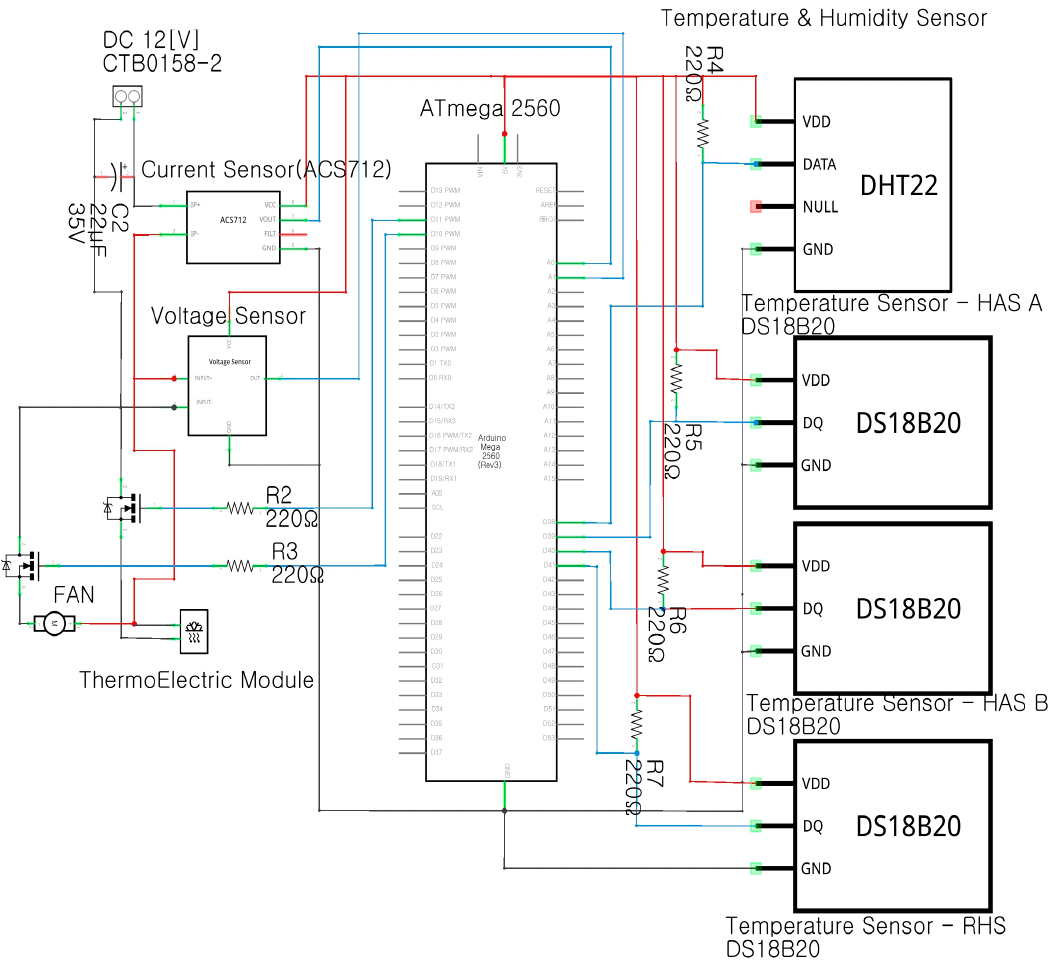
Figure 11. System structure and circuit diagram for experiment. Table 5. Components used in the experiment.